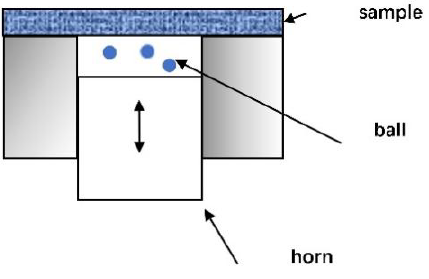
Figure 4. Schematic illustrations of the USSP process.